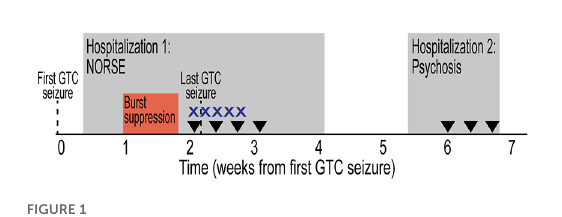
FIGURE1 Initial clinical presentation timeline. Timeline depicted from first GTC seizure. Hospitalizations designated by gray rectangles. Period of burst suppression designated by red box. Treatment with high-dose intravenous corticosteroids (X) and plasmapheresis (inverted triangle) are indicated. GTC, generalized tonic-clonic; NORSE, new onset refractory status